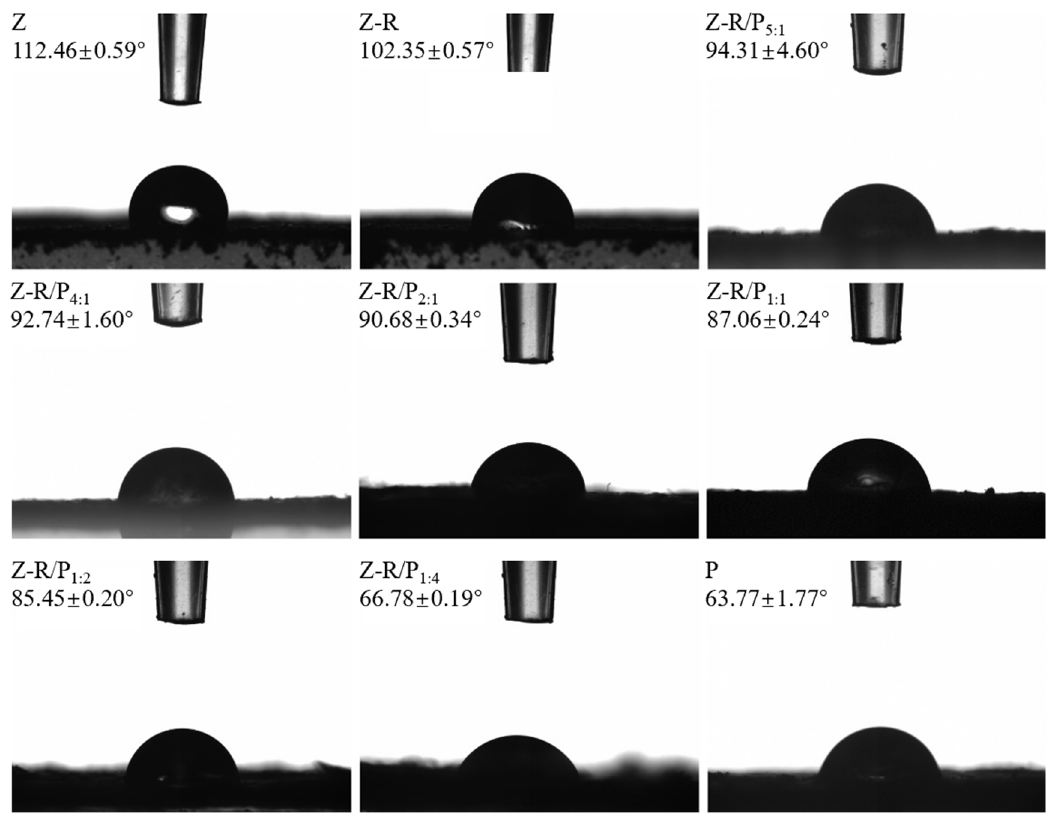
Figure 1. Three-phase contact angles of zein particles (Z), zein–resveratrol conjugates (Z-R), zein– resveratrol/pectin (Z-R/P) particles with different mass ratios of Z-R to P (5:1, 4:1, 2:1, 1:1, 1:2, 1:4) and pectin (P).